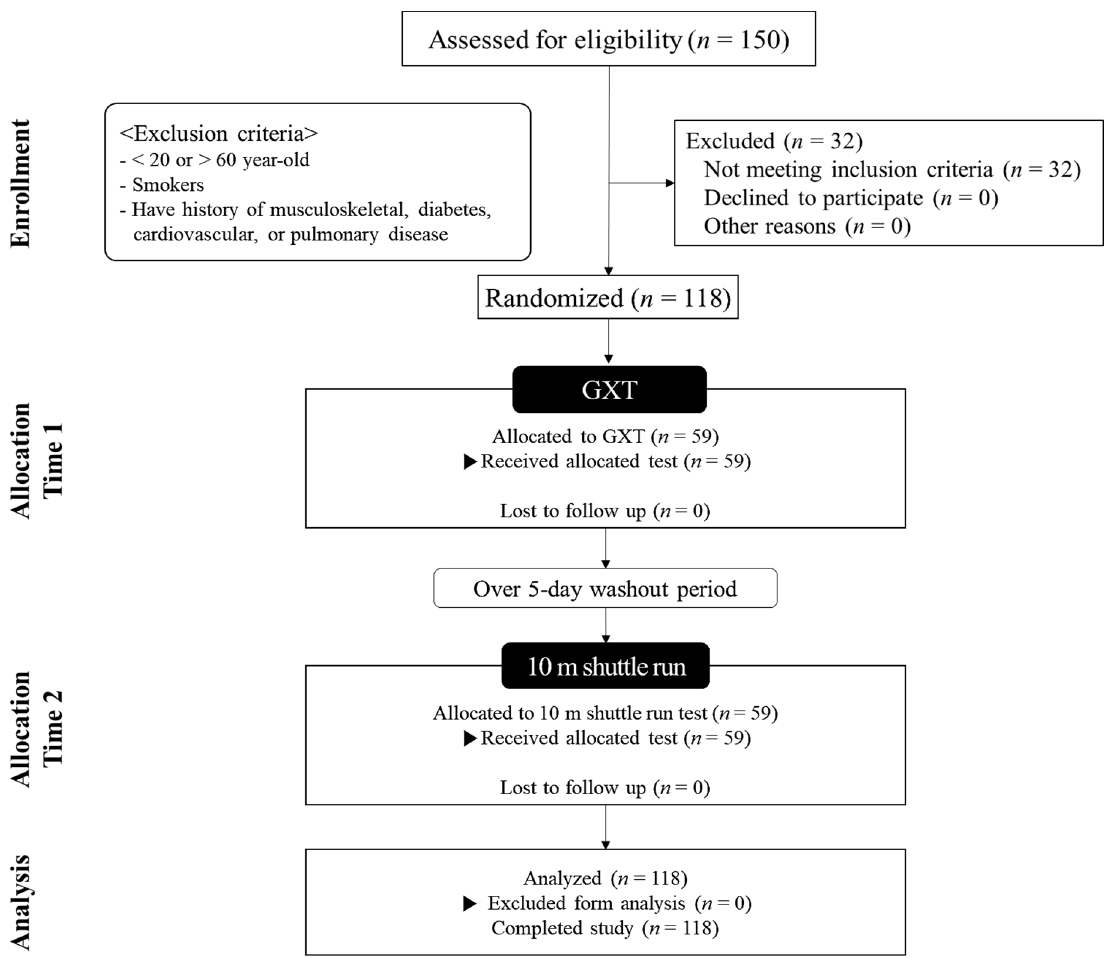
Figure 1. Consolidated Standards of Reporting Trials (CONSORT) flow diagram. GXT, graded exercise test.